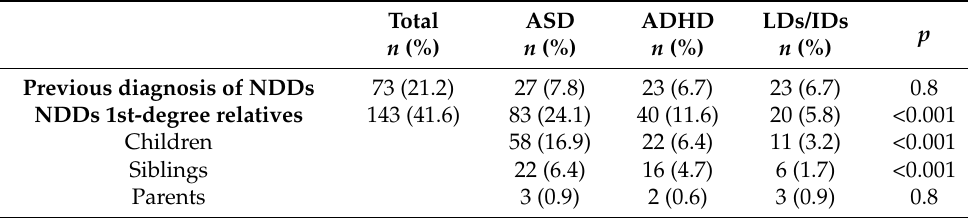
Table 2. Neurodevelopmental disorders data in the respondents and their first-degree relatives.